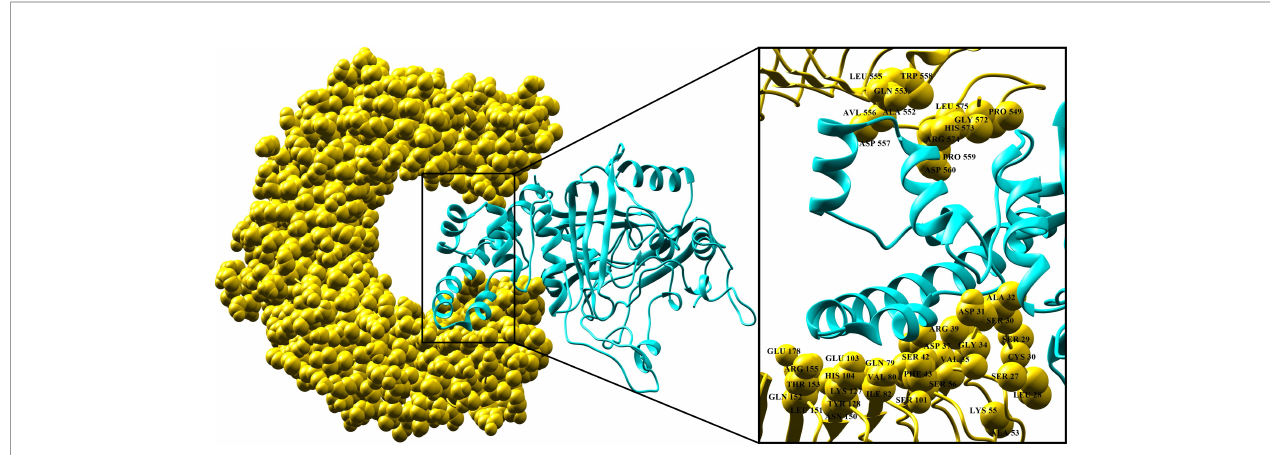
FIGURE 5 | Docking pose of vaccine and TLR-2 receptor. TLR-2 receptor is in yellow and vaccine construct is in cyan. Interaction residues of the receptor are shown on the right-hand side.